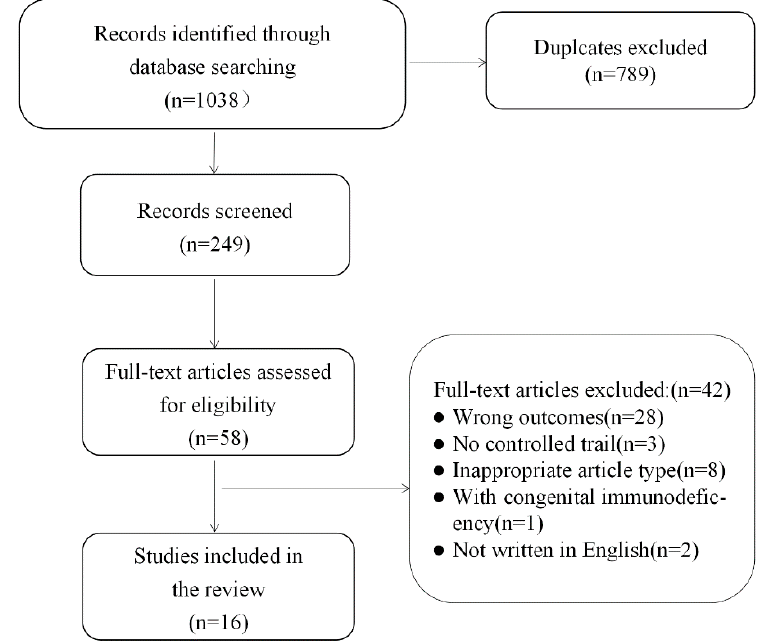
Figure 1. Literature search and screening process.